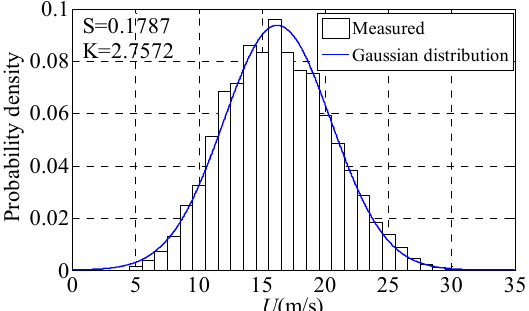
Figure 14. Probability density of total wind speed samples in the whole landing process of Typhoon Sarika.